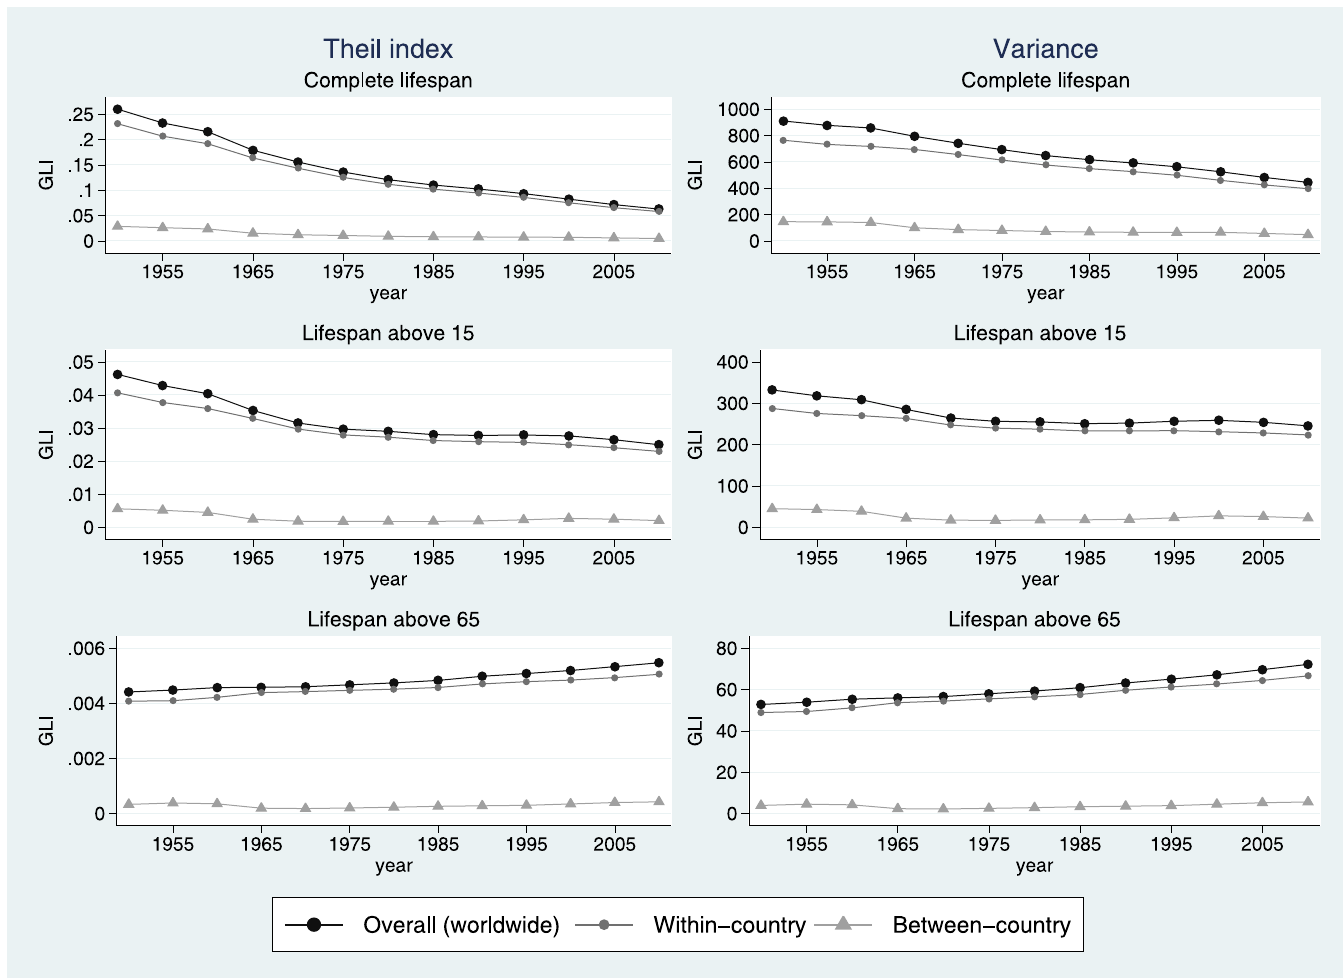
Fig 3. Global lifespan inequality between 1950–55 and 2010–15 using the Theil index and the variance (left and right columns, respectively) for overall, adult and elderly populations. Source: Authors’ calculations based on UN World Population Prospects